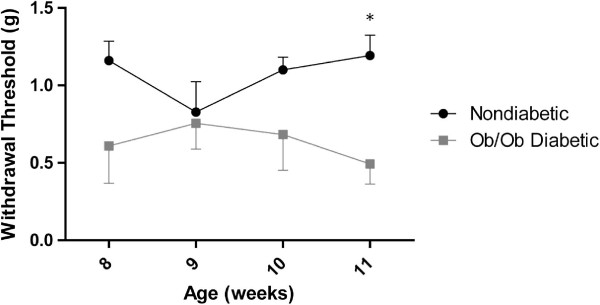
Ob/ob mice develop mechanical allodynia. Mechanical thresholds were tested using von Frey monofilaments at 8, 9, 10, and 11 weeks of age. Ob/ob mice did not display significant differences from nondiabetic controls at 8, 9, or 10 weeks. However, at week 11, ob/ob mice had a significant decrease in their mechanical withdrawal thresholds. * = p < 0.05. n = 6 nondiabetic mice, n = 6 ob/ob diabetic mice.